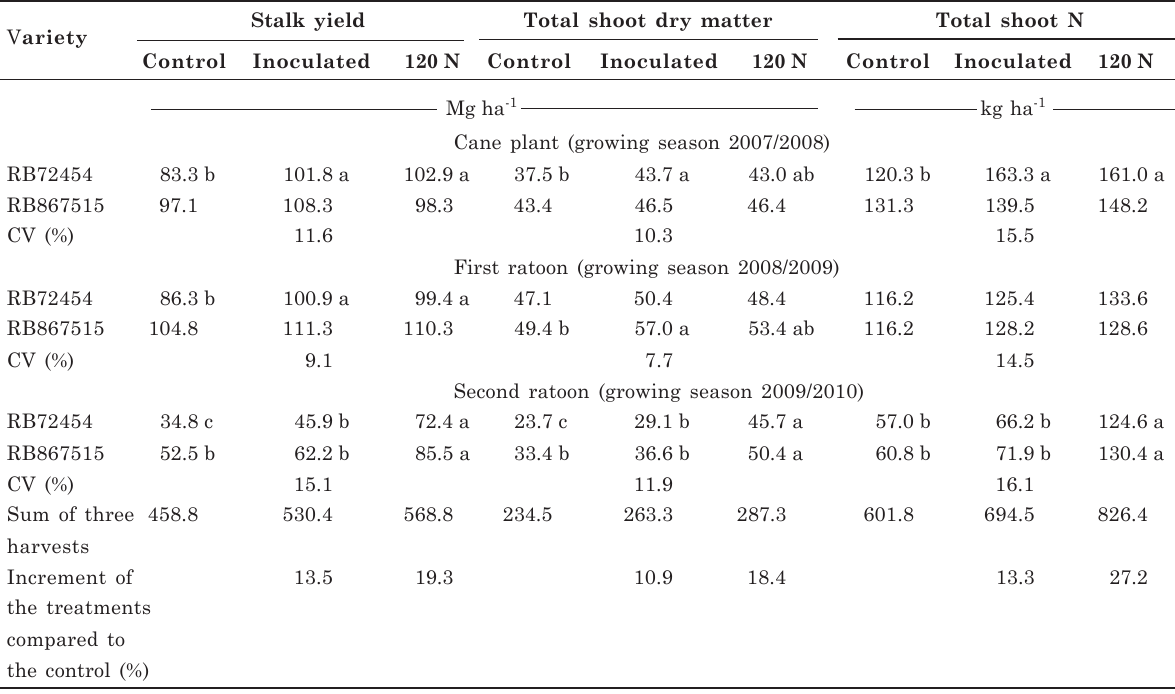
Mean of four replications. Values followed by different letters in rows do not differ by the LSD t test at 10 % significance. The sum of three harvests and percentage values of increments of the treatments compared to the control were not subjected to statistical